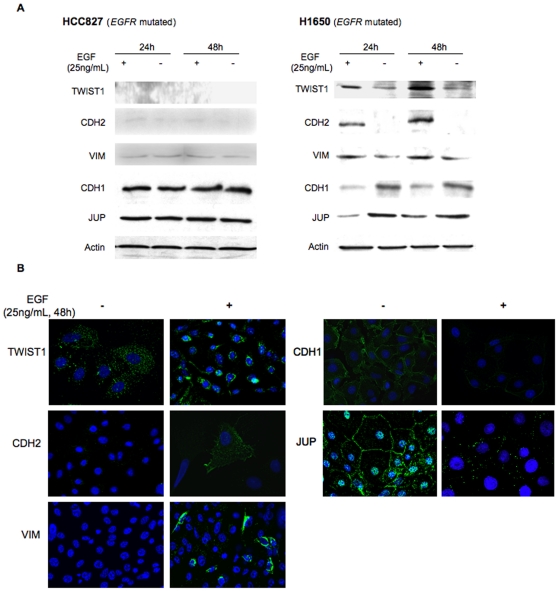
EGF induces EMT only in cells with EGFR mutation and TWIST1 expression (protein level).
A. Assessment of TWIST1, CDH2, VIM, CDH1 and JUP expression by western blotting after addition of EGF for a 24 h or 48 h period of time on HCC827 (EGFR mutated, TWIST1 not expressed) and H1650 (EGFR mutated, TWIST1 expressed). B. Representative photomicrographs of TWIST1, CDH2, VIM, CDH1 and JUP expression analyzed by immunofluorescence after EGF treatment (25 ng/mL).